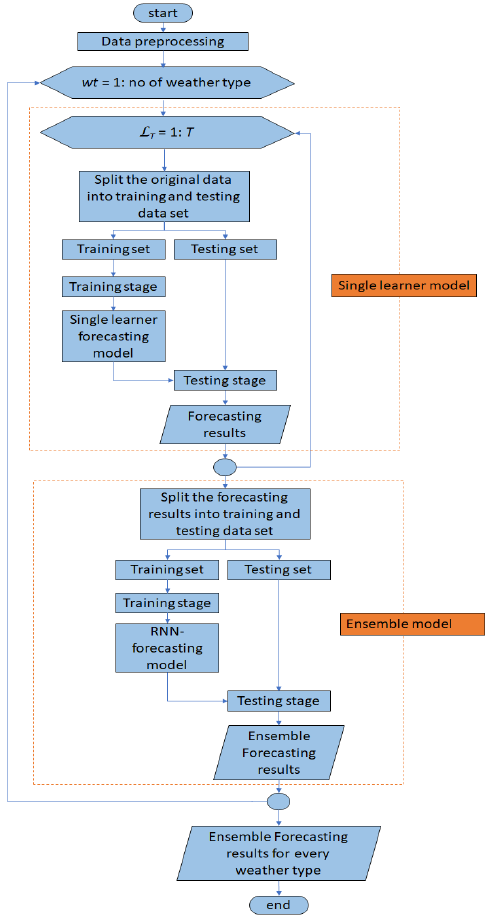
Figure 7. The detailed process of the proposed ensemble forecasting algorithm. Figure 6. The RNN